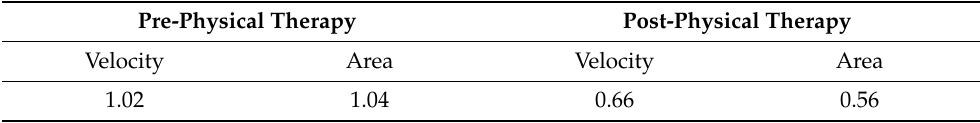
Table 4. Single-Leg Postural Steadiness Ratio: Affected/Unaffected